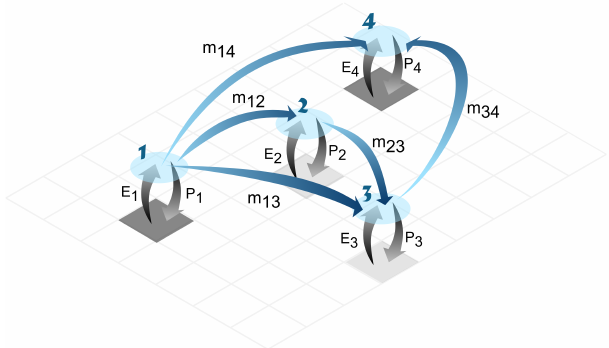
Fig. B2: Different CMR pathways from grid cell 1 to grid cell 4 . The contribution of the direct pathway is W 1 , 4 = m 14 /P 4 , Figure B2. Different CMR pathways from grid cell 1 to grid thecontribution ofthepathinvolving onere-evaporationcyclein gridcell 3 is W 1 , 3 , 4 = m 13 /P 3 of the path involving re-evaporation cycles in grid cells 2 and 3 is W 1 , 2 , 3 , 4 = m 12 /P 2 same that in Fig. 3.